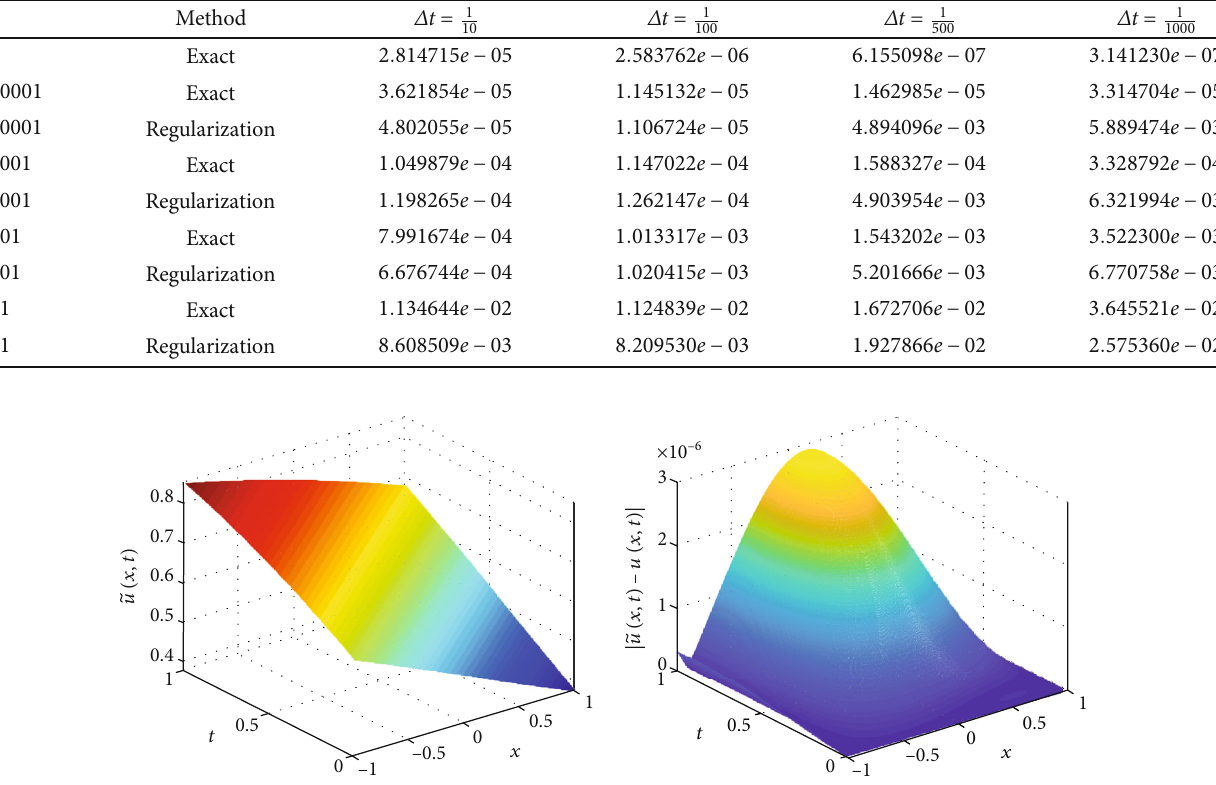
Table 1: L ∞ errors of Example 1 for di